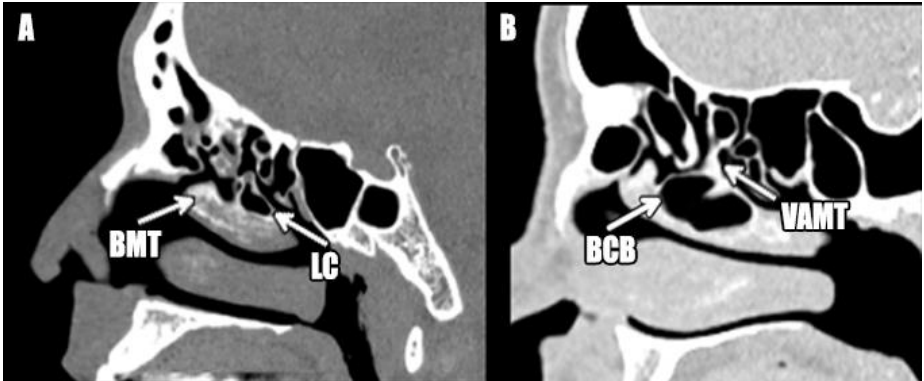
Figure 2. Bulbous and lamellar concha bullosa: ( A ): Lamellar concha bullosa. Note that the cell is only lamellar cell (LC) and is not affecting the body of the middle turbinate (BMT). ( B ): Bulbous concha bullosa (BCB). Note that the cell is not affecting the vertical aspect of the middle turbinate (VAMT).